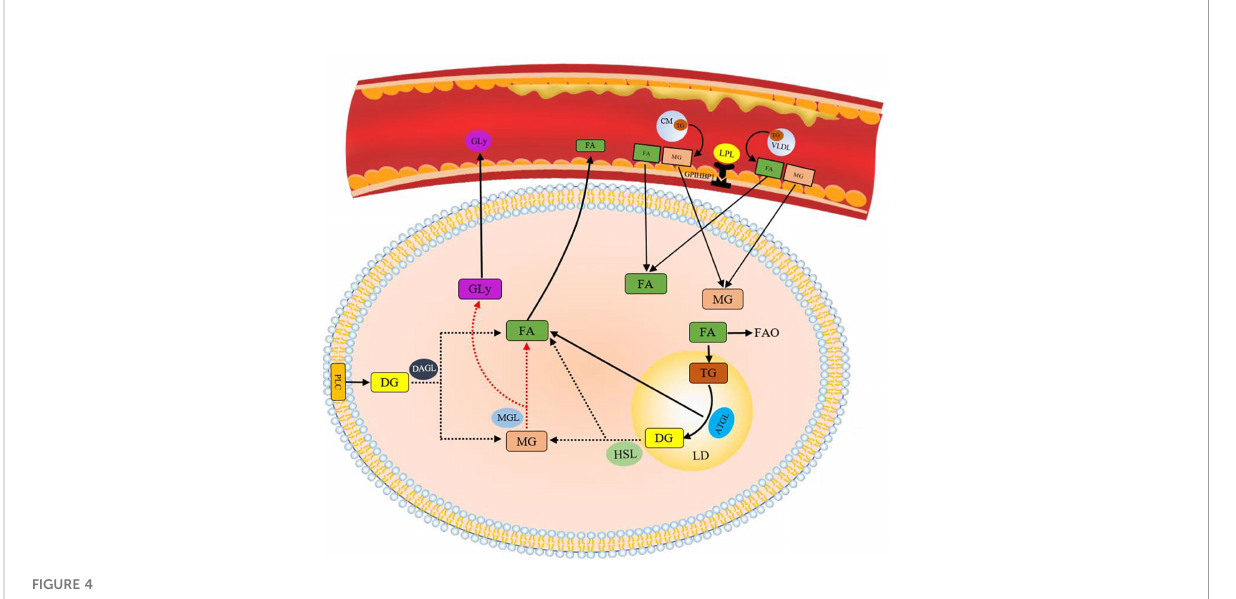
FIGURE 4 Lipids obtained by decomposition.